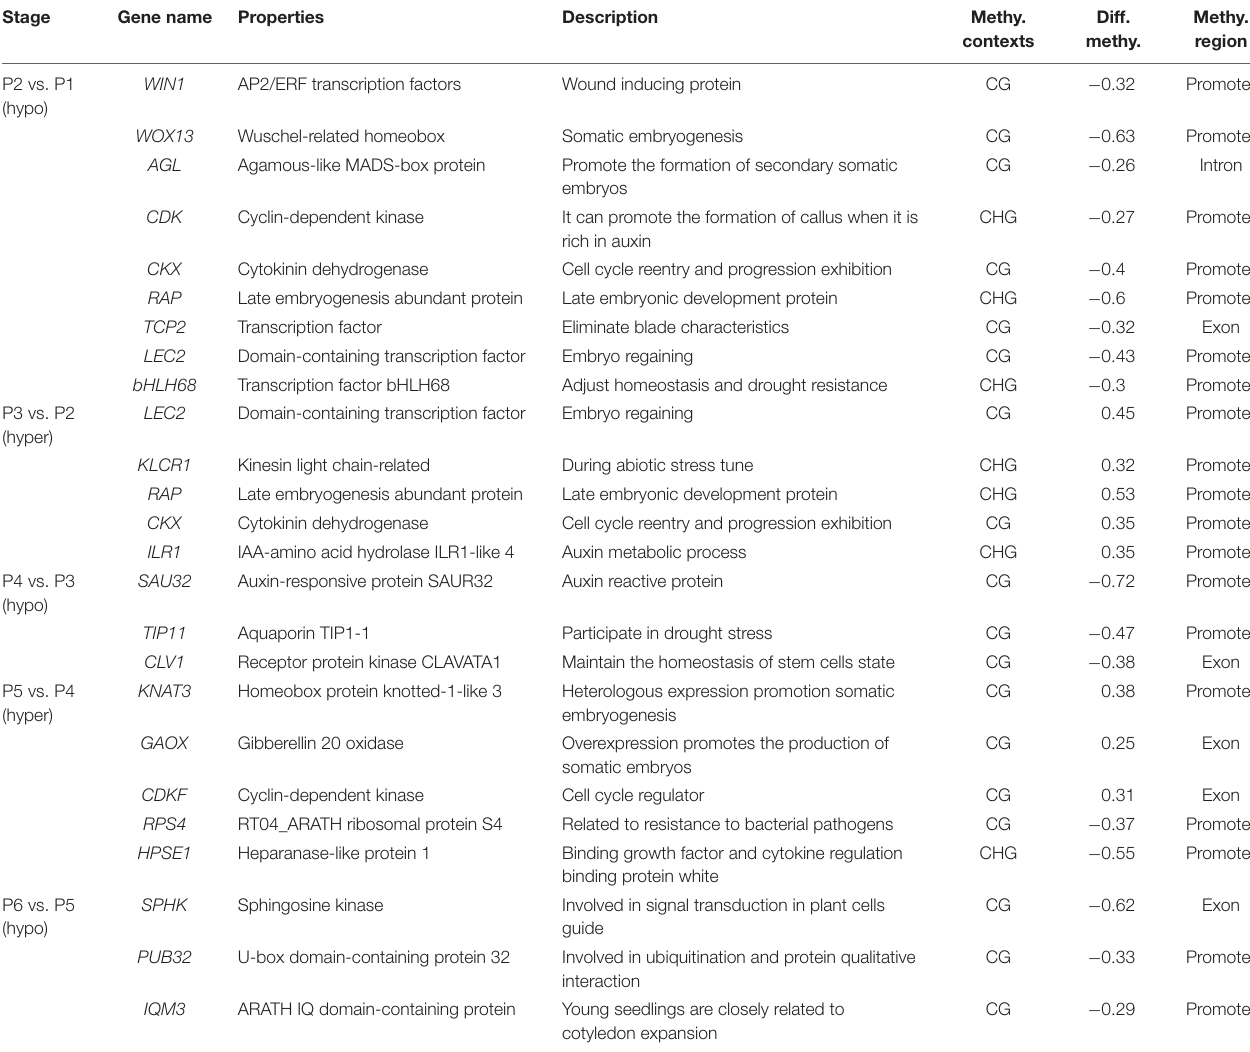
TABLE 2 | List of important genes of methylation differences at different stages of tissue culture of F. nilgerrensis.